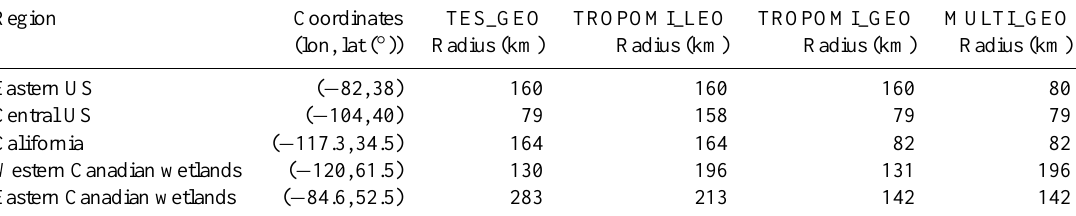
Table 2. Coordinates of the five locations considered for the rows of the model resolution matrix and approximate radius of influence of neighboring grid cells (see text), for each satellite configuration and a weekly methane flux inversion.